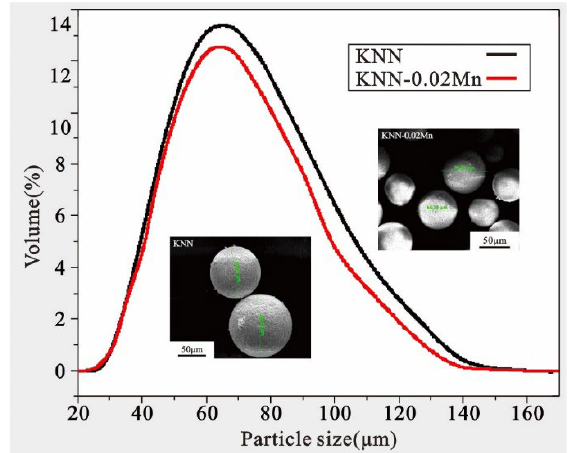
Figure 2. KNN and KNMN powder particle size.